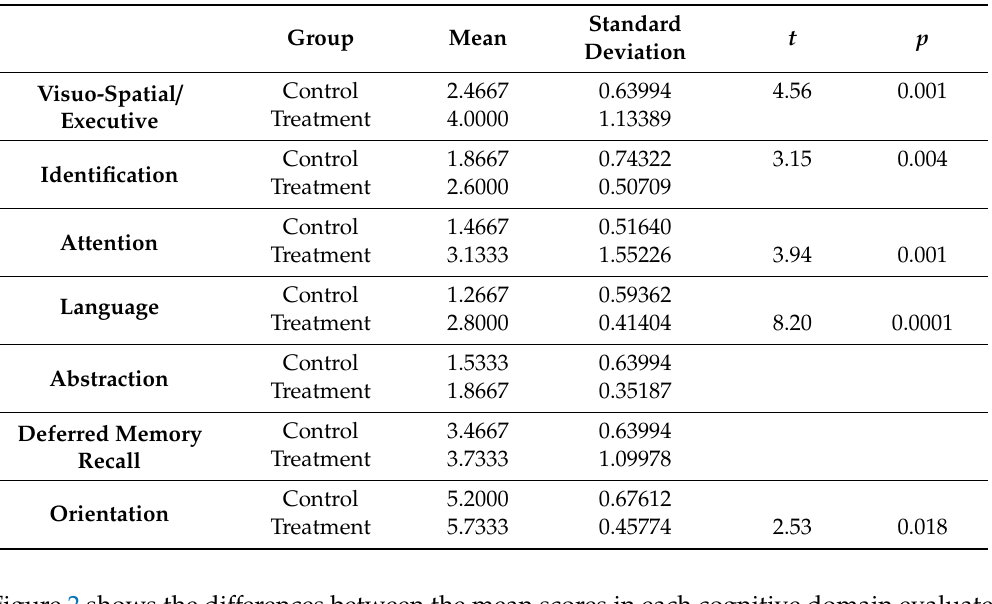
Table 2. E ff ect of training in the di ff erent areas evaluated by MoCA in the treatment group compared to the control group.